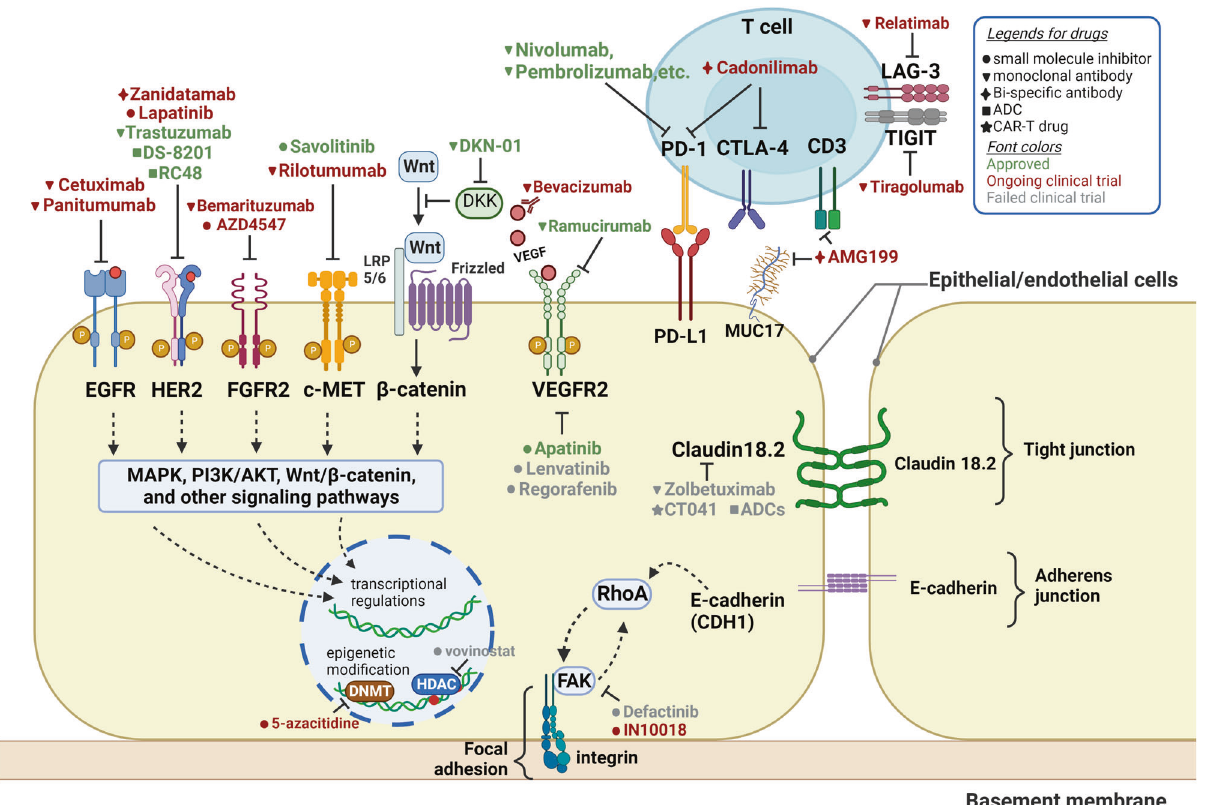
receptor, MAPK mitogen-activated protein kinase, HER2 human epidermal growth factor receptor 2, PI3K phosphoinositide 3-kinases, FGFR2 fi broblast growth factor receptor 2, VEGFR2 vascular endothelial growth factor receptor 2, FAK focal adhesion kinase, RhoA Ras homolog family member A, PD-1 programmed death 1, PD-L1/2 programmed death ligand 1/2, ADC antibody-drug conjugate, LRP5/6 low-density lipoprotein receptor-related protein 5/6, DKK Dickkopf, CTLA-4 cytotoxic T-lymphocyte-associated protein 4, CD3 cluster of differentiation 3, TIGIT T cell immunoreceptor with Ig and ITIM domains, LAG-3 lymphocyte-activation gene 3, DNMT DNA methyltransferase, HDAC Histone deacetylases. This fi gure was created with